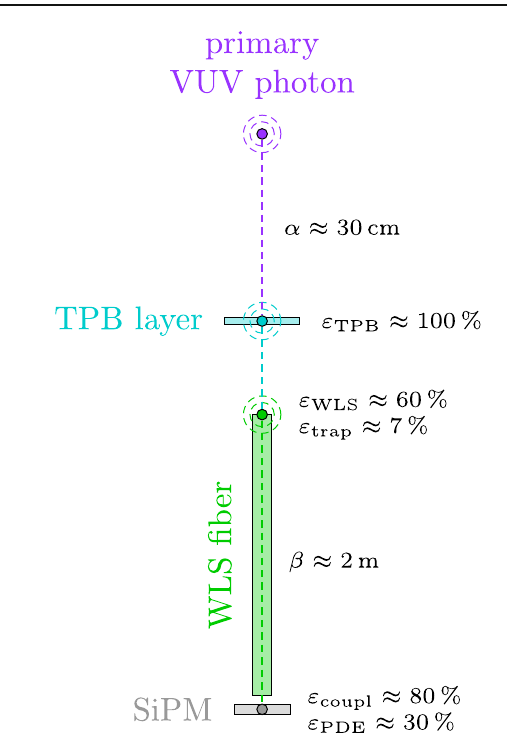
Fig. 2 Simplified light collection chain. This one-dimensional repre- sentation depicts the main material properties that affect the light col- lection with the Gerda fiber-SiPM instrumentation. The overall light collection efficiency for the primary VUV photon is of O (0.1)%. In real life, effects like shadowing, reflections and optical coverage enter the game